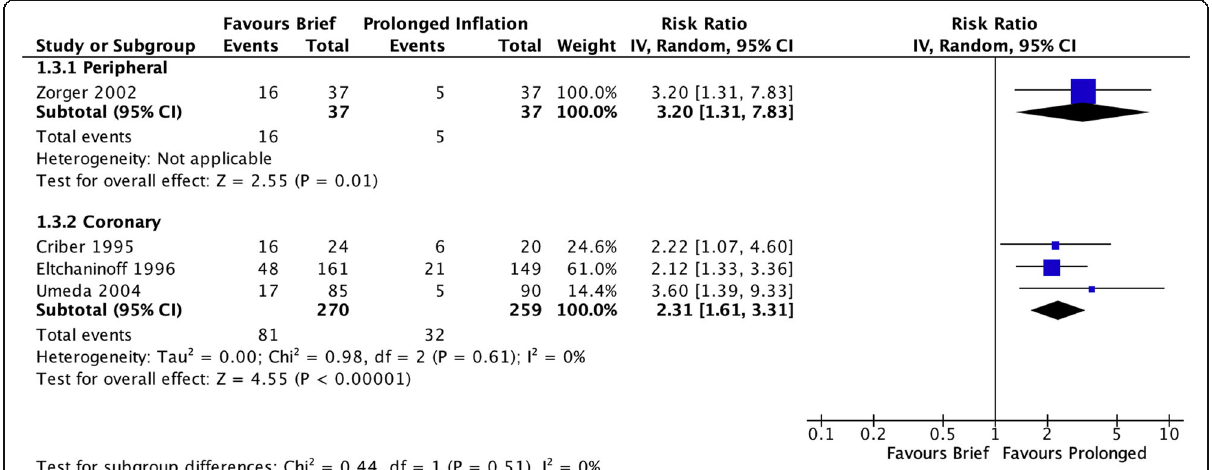
Fig. 4 Risk of arterial dissection apparent immediately after initial angioplasty inflation